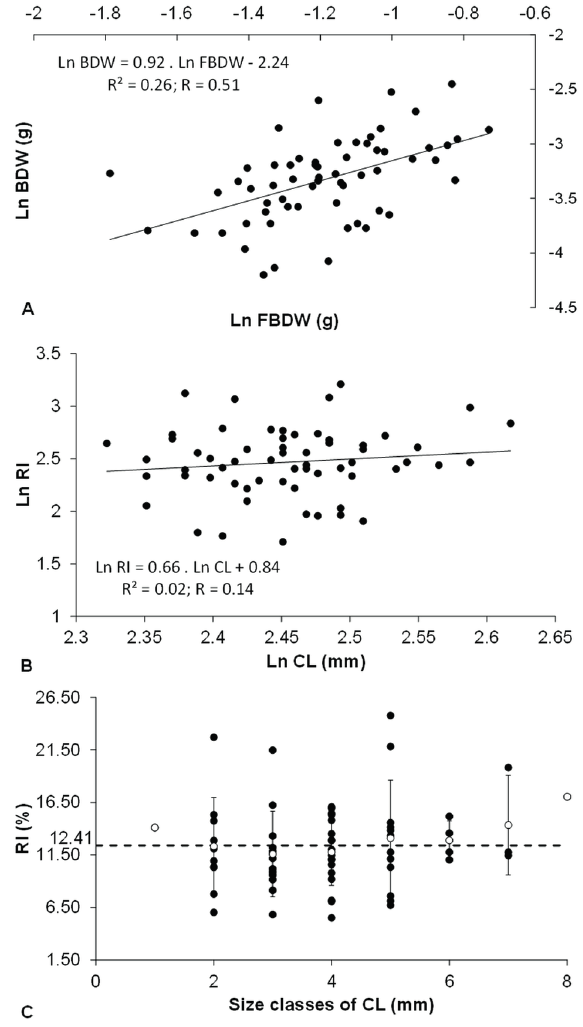
Figure 1. Nematopalaemon schmitti (Holthuis, 1950). Reproductive investment (RI) by: A) female body dry weight (FBDW) and brood dry weight (BDW) (g); B) carapace length (CL) (mm); C) size classes of carapace length (mm).